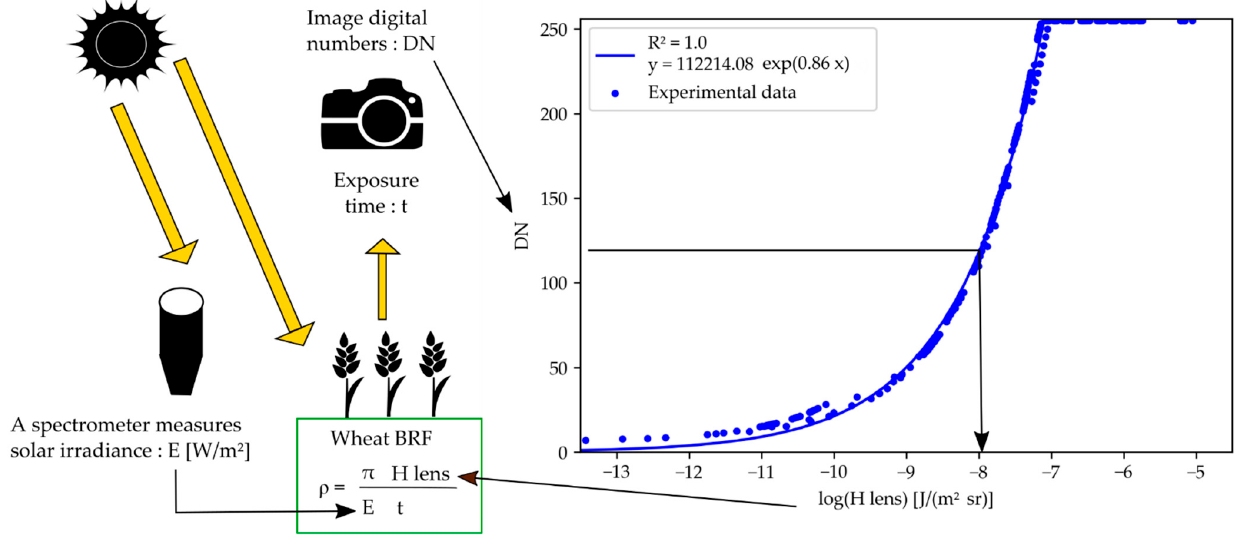
Figure 2. Method to compute wheat bi-directional reflectance factor (BRF) from image digital numbers and ILS readings. The method exploits the camera response curve. H lens is the exposure at camera lens.